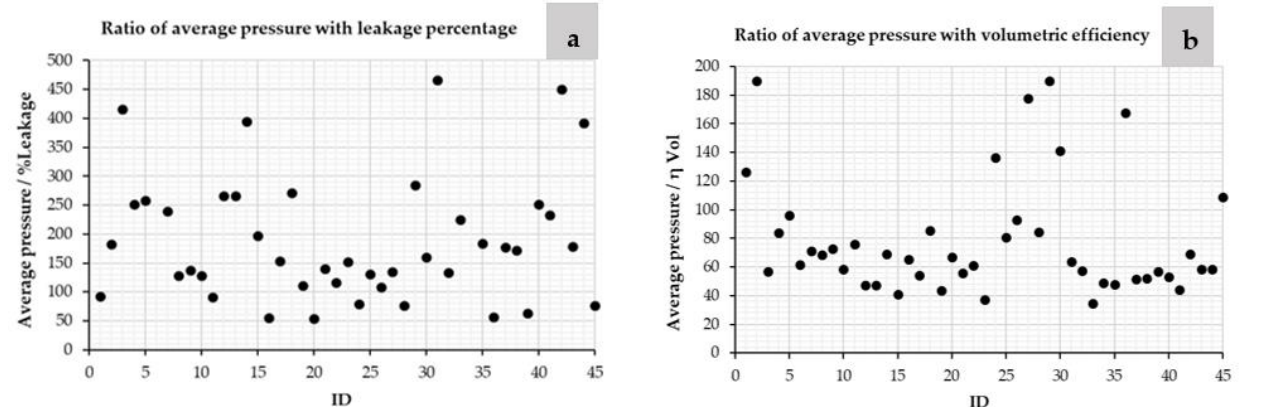
Figure 4. Ratio between average pressure with leakage percentage ( a ) and volumetric efficiency ( b ). In energy terms, the value of average pressure and flow injected into the network-